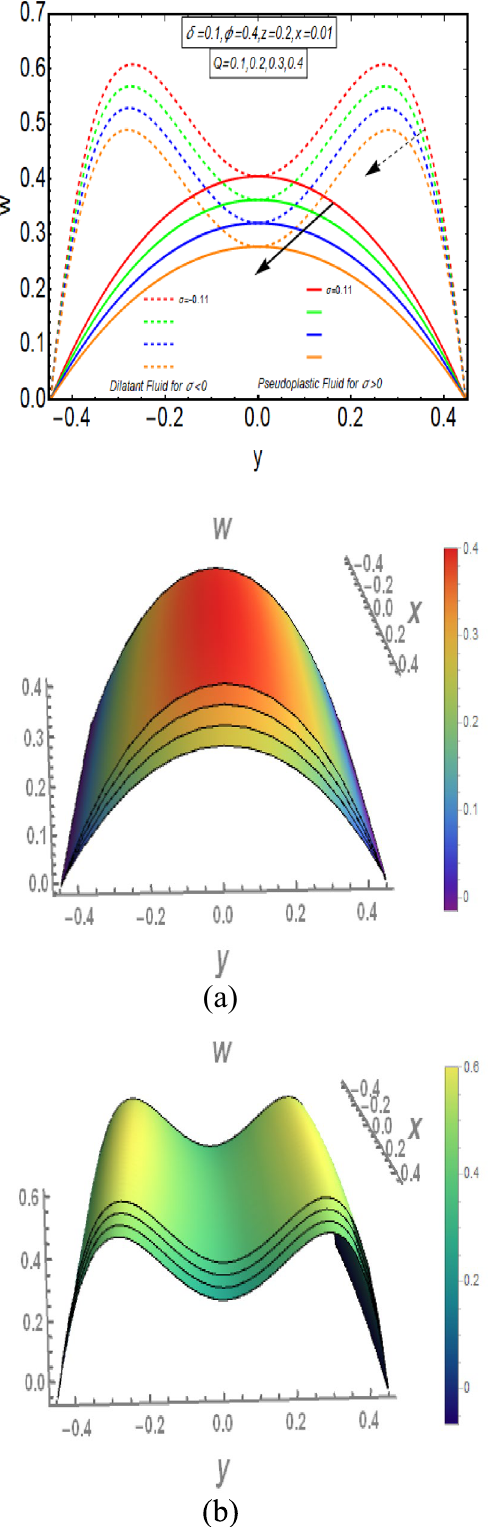
Figure 2. Velocity Profile for Q with σ > 0 and σ < 0 . ( a ) σ > 0, ( b ) σ <